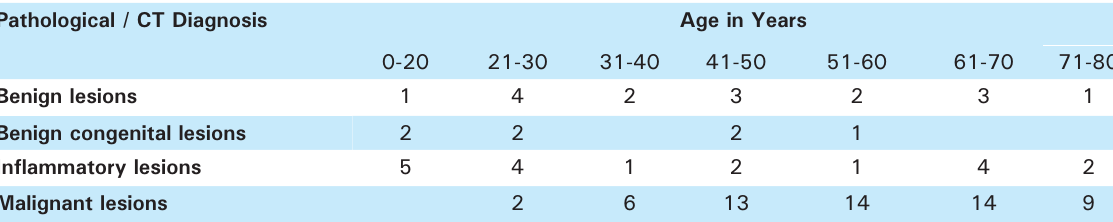
Table 1. Diagnosis of various neck lesions according to age distribution.